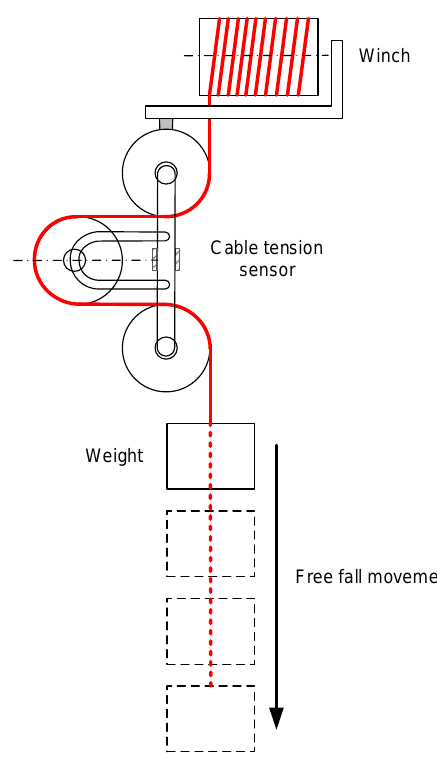
Figure 14. Sketch of the dynamic test approach. Table 2. Weights employed for device validation and